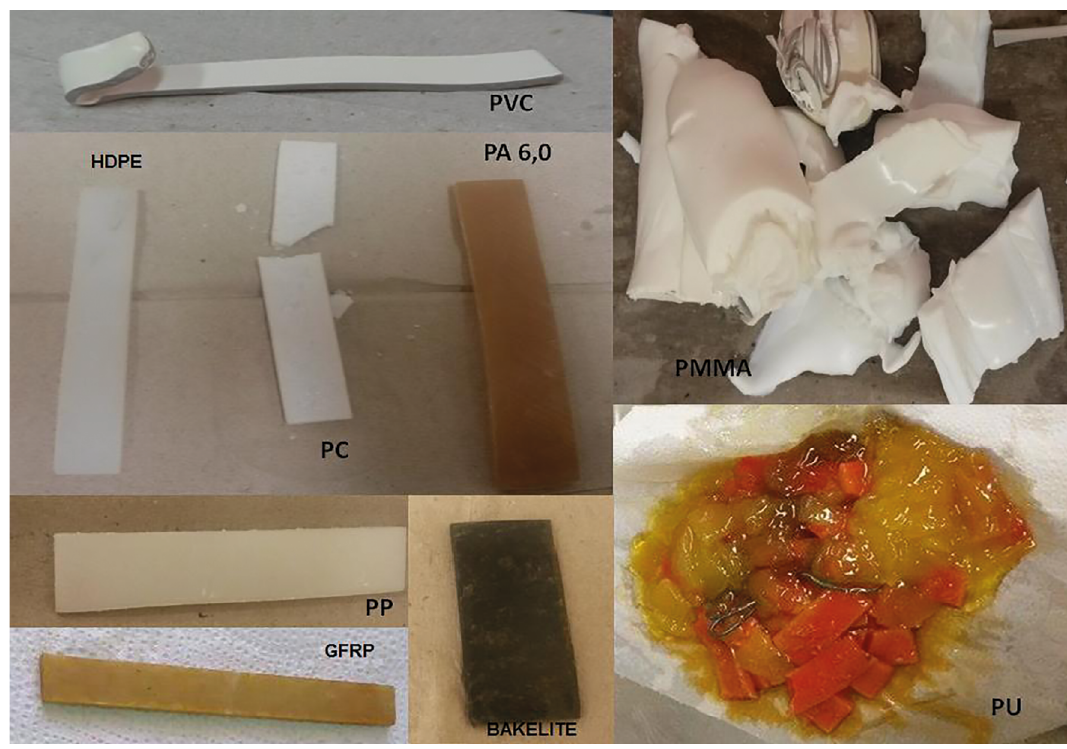
Figure 2. Image of the tested materials after the chemical resistance test. Table 2. Area variation for the materials after chemical resistance testing.